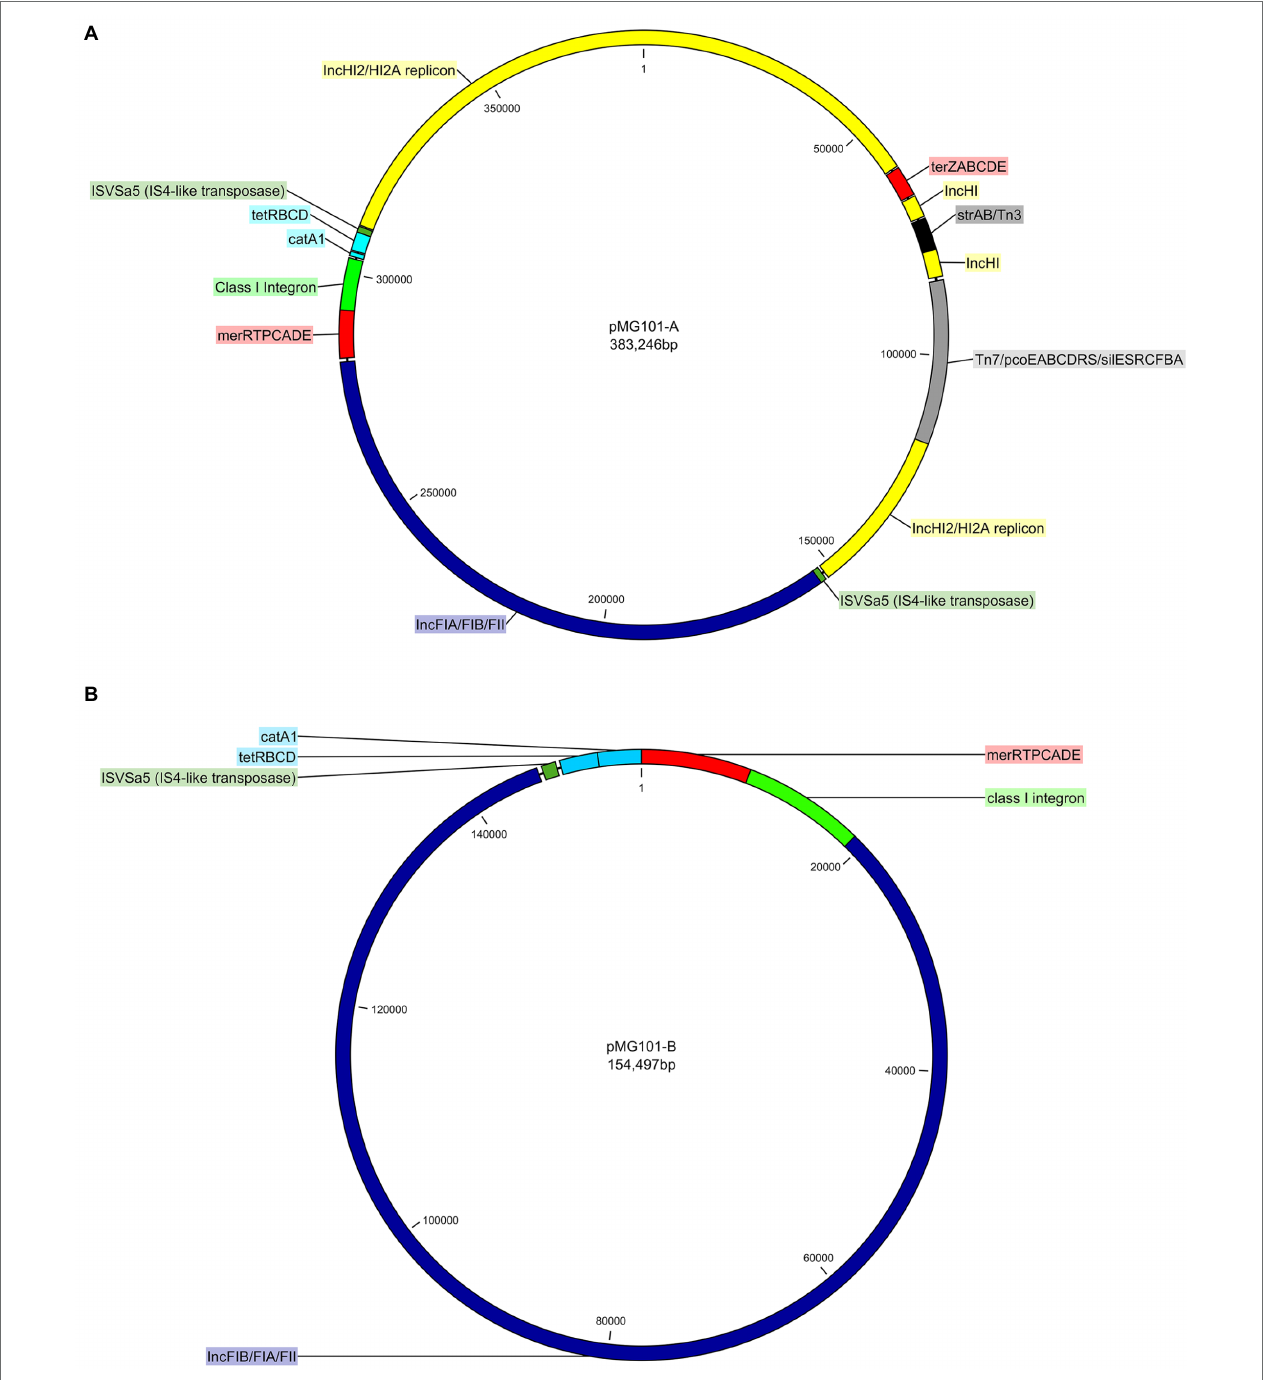
FIGURE 1 | (A) Circular genetic map of IncH/IncF plasmid pMG101-A – the IncHI2/HI2A replicon (yellow), IncFIA/FIB/FII component (blue), Tn 7 / pco / sil mobile unit (grey), ter and mer metal resistance operons (red), Tn 3 / strAB antimicrobial resistance gene (ARGs; black), tetBCD / catA1 (light blue), class I integron (light green), and two copies (dark green) of ISVSa5 (IS4-like transposase) are all highlighted. (B) Circular genetic map of IncF plasmid pMG101-B – the IncFIA/FIB/FII backbone of pMG101-B (blue), class I integron (light green), tetBCD / catA1 (light blue), mer operon (red), and a single copy (dark green) of ISVSa5 (IS4-like